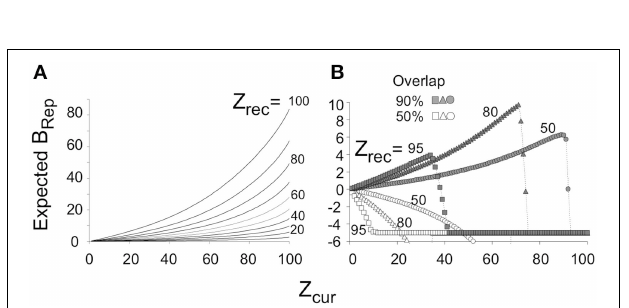
FIGURE 4 | Expected B Rep values as a function of Z cur for various values of Z rec . (A) Expected B Rep as a function of Z cur when BACON is tested in a context that is more or less well-known (differing Z rec values). (B) If BACON is placed in a novel context that is somewhat similar to one for which there is a representation, the representation of the known context will become active. Expected B Rep for this representation as a function of Z cur is shown for several degrees of similarity between the two contexts and several levels of Z rec for the encoded context. When the current context and the familiar one are not very similar, B Rep goes negative from the very start of the session and does so more rapidly, the better known (i.e., the greater the Z rec of) the familiar context. When the two contexts are similar, B Rep also eventually goes negative and does so sooner the more is known about the familiar context. However, especially at intermediate values of Z rec , B Rep for the previously familiar context first becomes quite